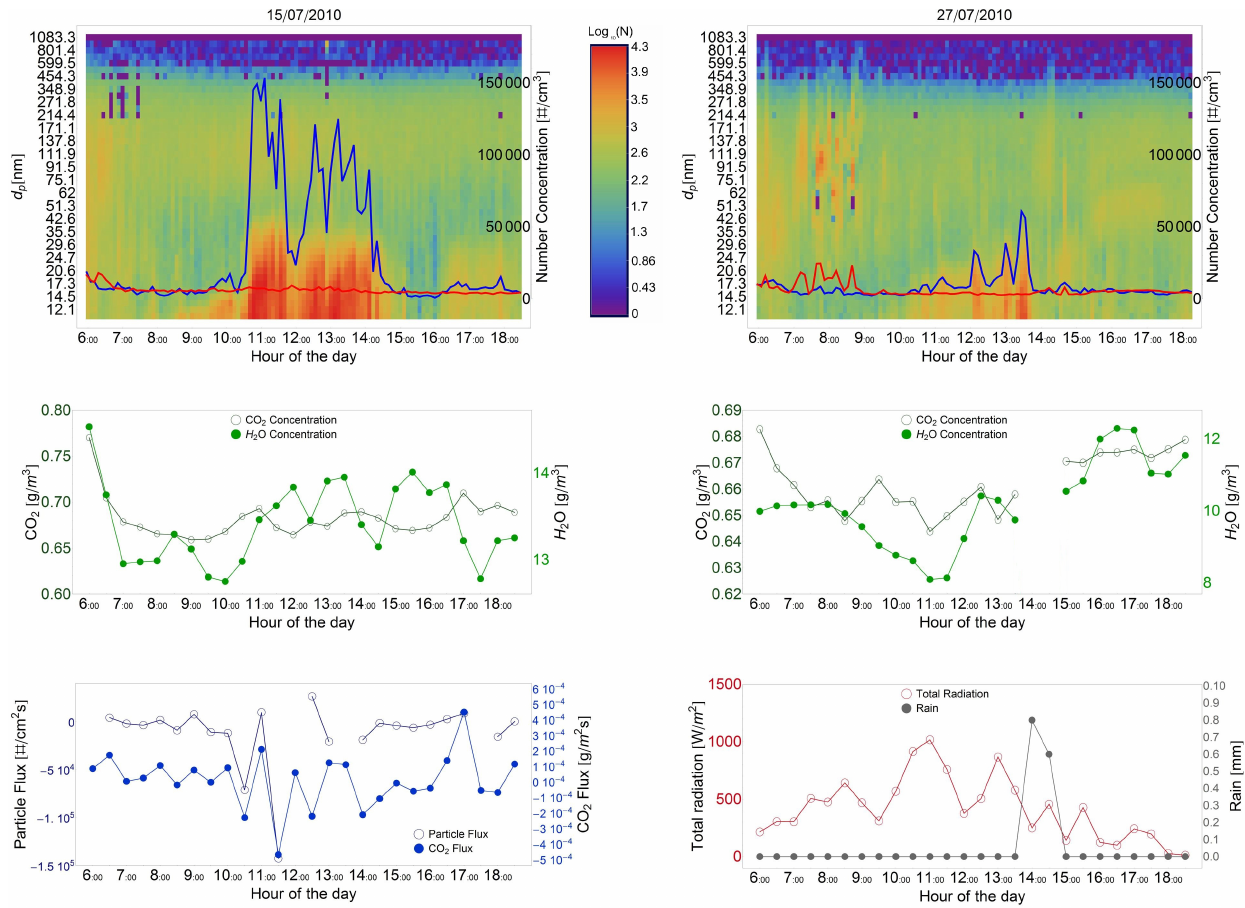
Figure 5. Evolution of the size distributions during two event days (15 July 2010 in the left panel, 27 July 2010 in the right panel) with N and H O concentrations are also shown for the two events. F 2 15 July 2010, and solar radiation and precipitation are shown for 27 July